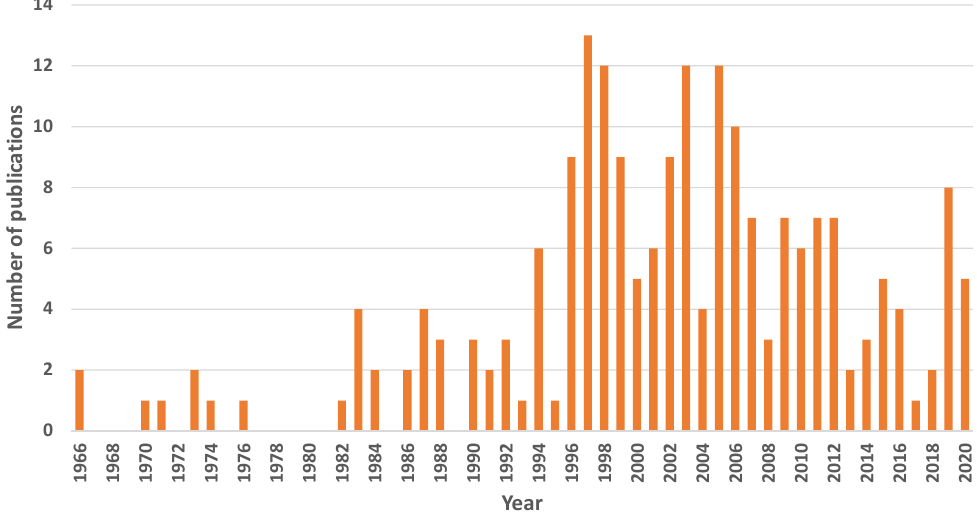
Figure 4. Distribution of publications over the